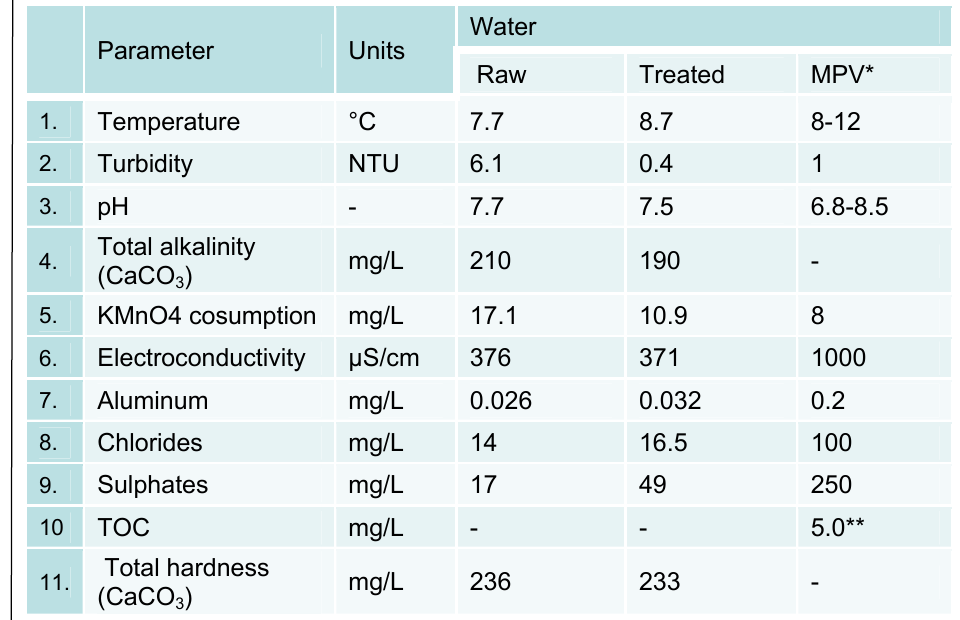
Table 1 – Results of physico-chemical analysis of surface water, February